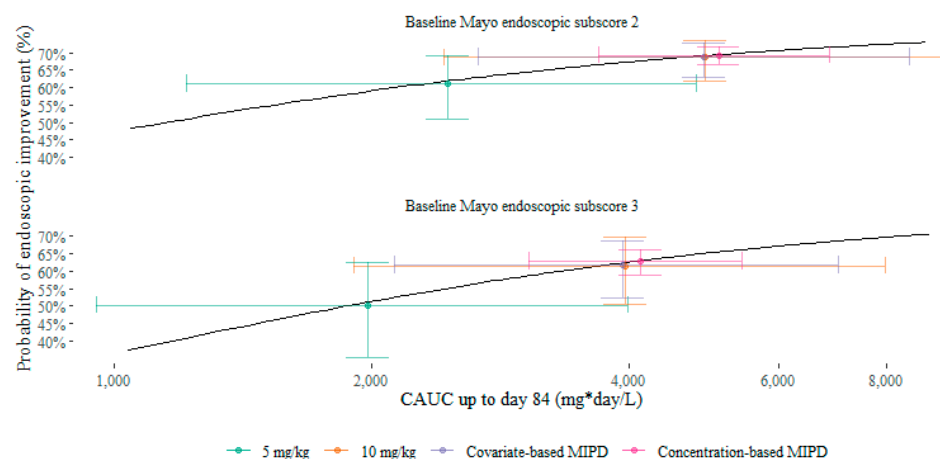
Figure 2. ( a ) Density plots of exposure in each of the four dosing scenarios, per baseline Mayo endoscopic subscore. Ver- tical lines show median exposure per scenario. ( b ) Density plots of the mean doses in each of the four dosing scenarios, per baseline Mayo endoscopic subscore. Vertical lines show overall mean dose per scenario. ( c ) Density plots of the indi- vidual probability of endoscopic improvement in each of the four dosing scenarios, per baseline Mayo endoscopic sub- score. Vertical lines show overall mean pEI per scenario. CAUC, cumulative area under the curve; MIPD, model-informed precision dosing; pEI, probability of endoscopic improvement.